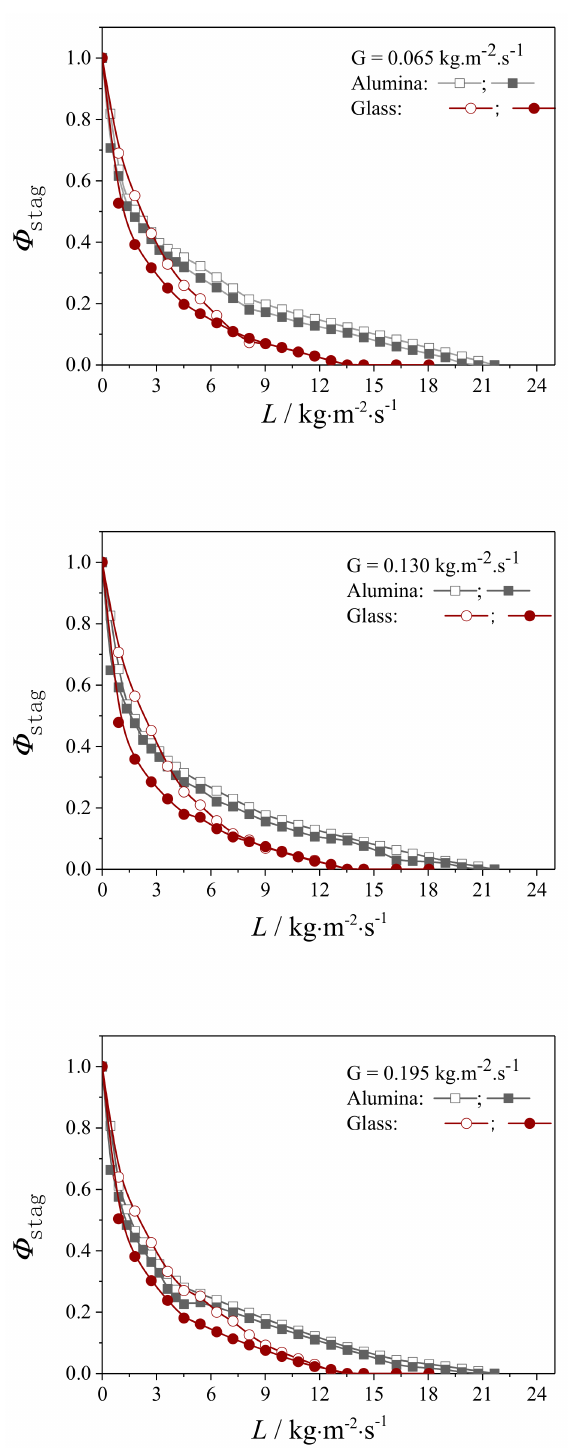
Figure 7. Fraction of stagnant liquid over the packing